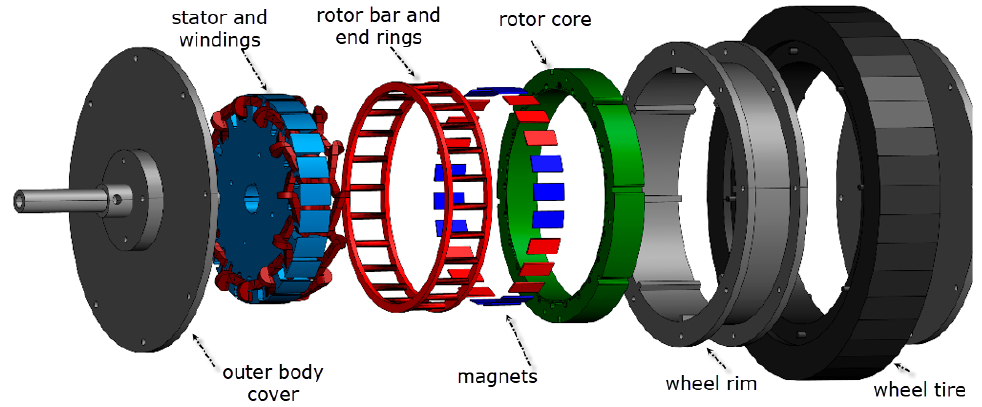
Figure 7. All parts of the proposed motor design.